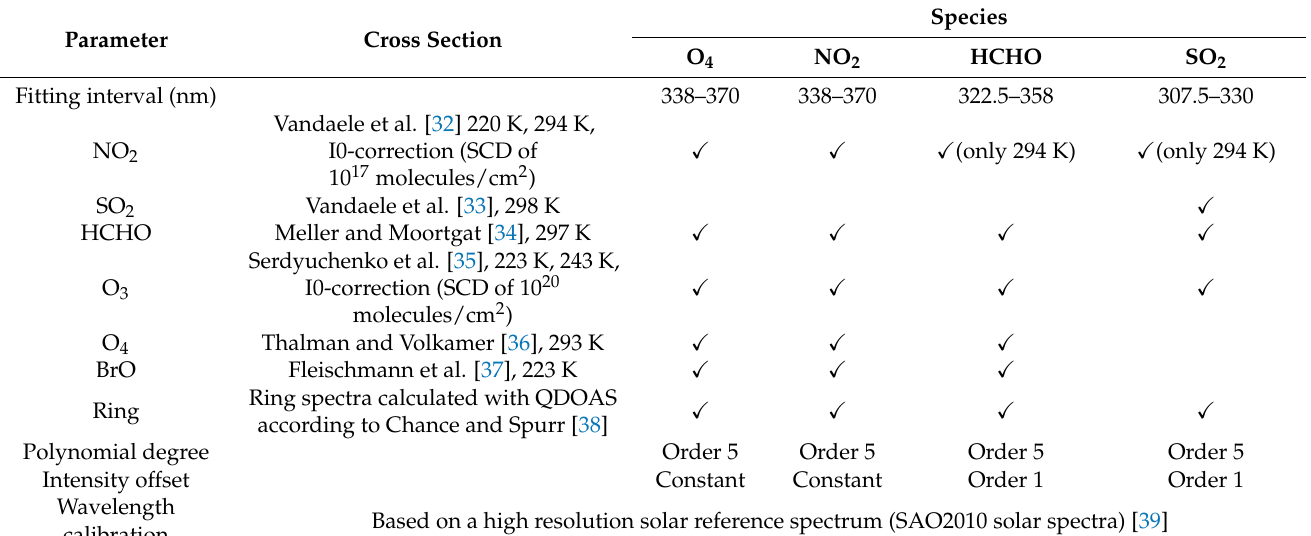
Table 1. Summary of the DOAS analysis settings used for the O 4 , NO 2 , HCHO, SO 2 dSCDs retrieval. Parameter Cross Section